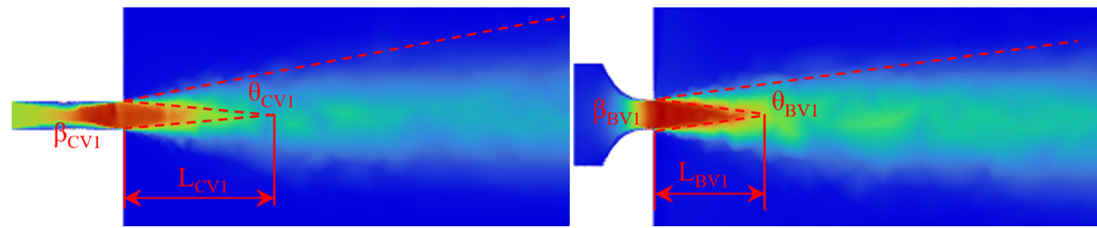
Figure 6. Detailed cloud map of the jet outlets of the equal-diameter nozzle and the standard nozzle with a compressed air pressure of 212,782 Pa and a temperature of 303 K.